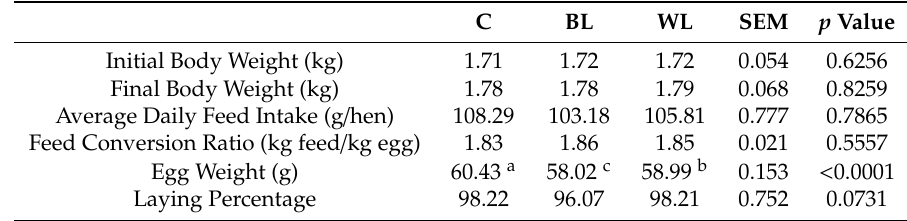
Table 3. The e ff ect of supplemental bilberry and walnut leaves on the productive parameters of the laying hens.